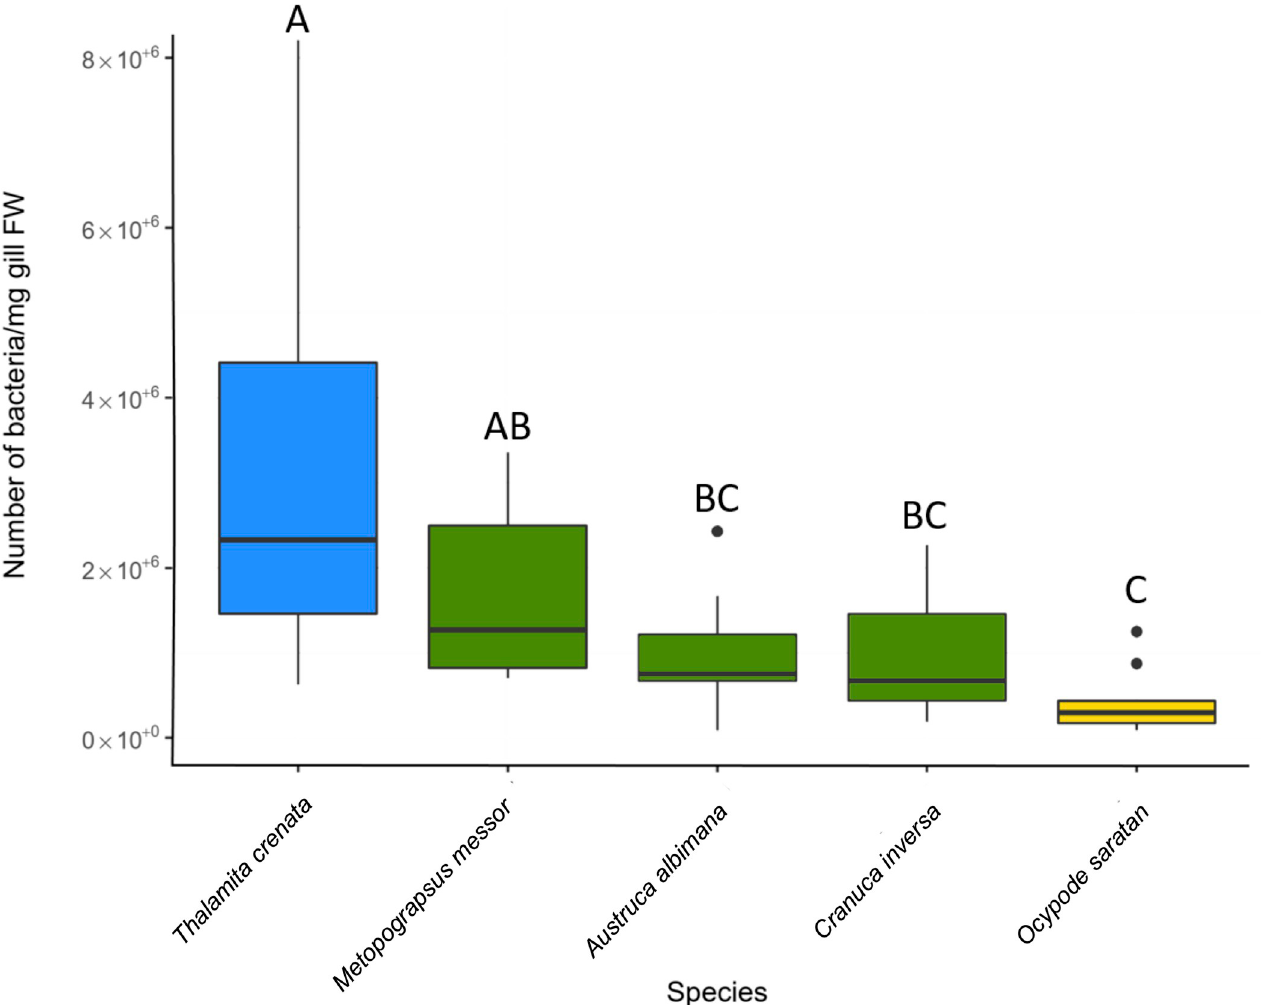
Fig 6. Bacterial quantification using qPCR analysis. Bacterial abundance on gills of five different mangrove crab species with different lifestyles along the tidal gradient. Letters indicate statistical significance ( p < 0.05) among the groups resulting from multiple pairwise comparisons. The colours indicate the intertidal levels: Blue = subtidal, green = intertidal, yellow = supratidal.